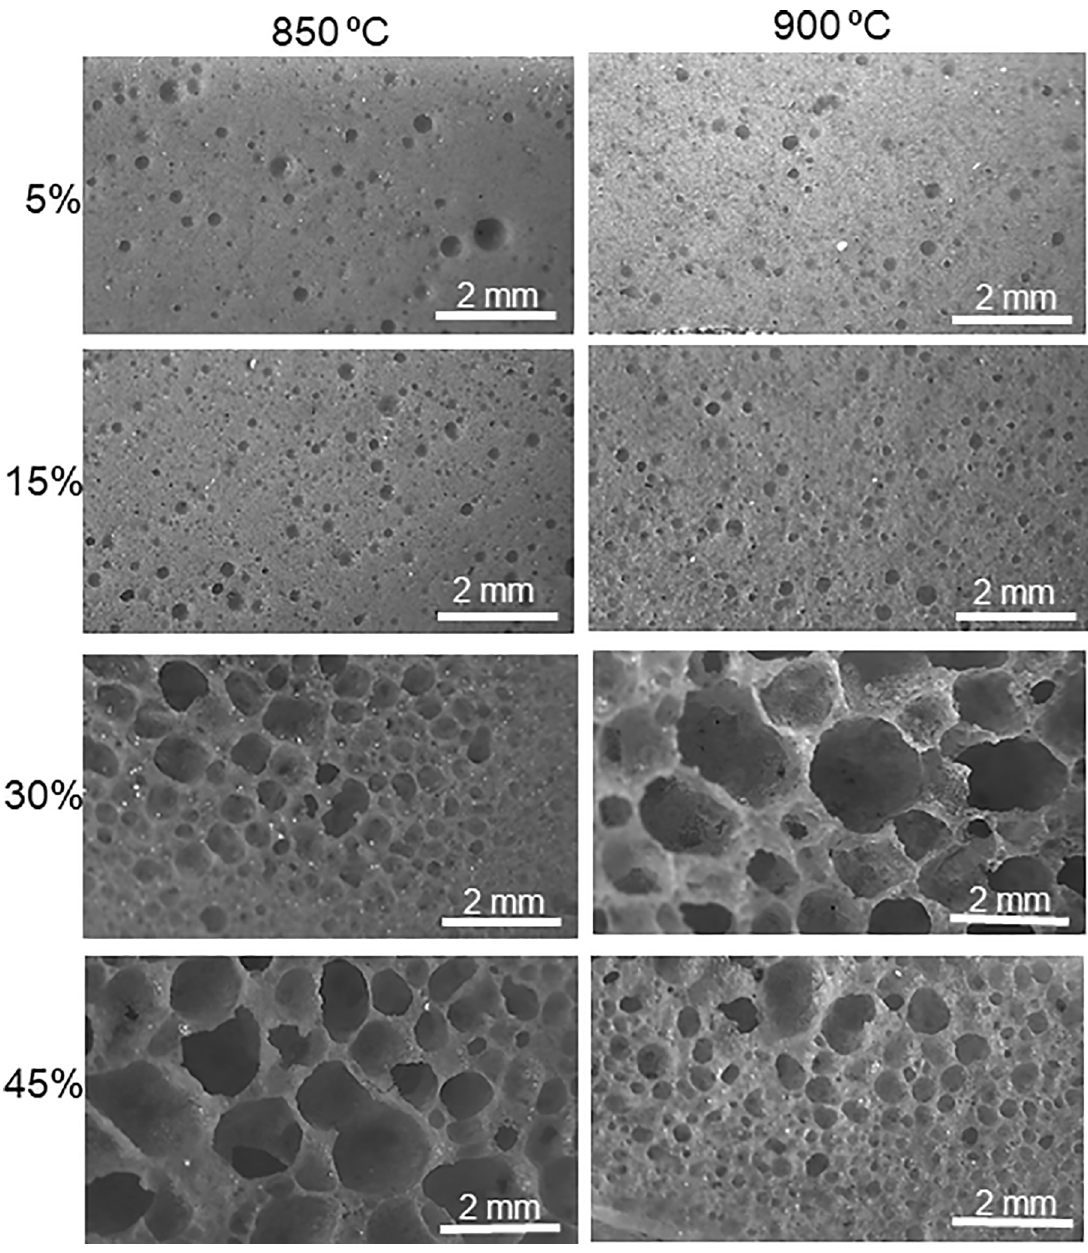
Figure 3. Optical microscopy of glass foams produced containing 5, 15, 30 and 45% (mass) of T and fired at 850 and 900